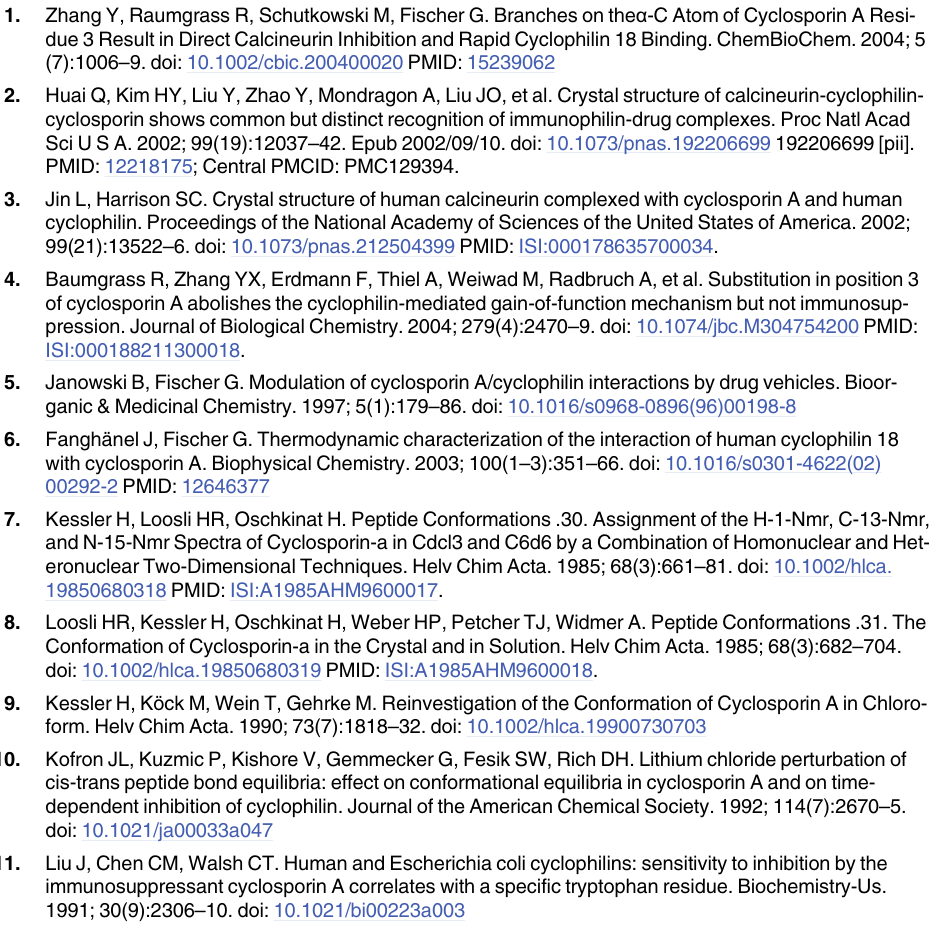
and k used for s-f f-s